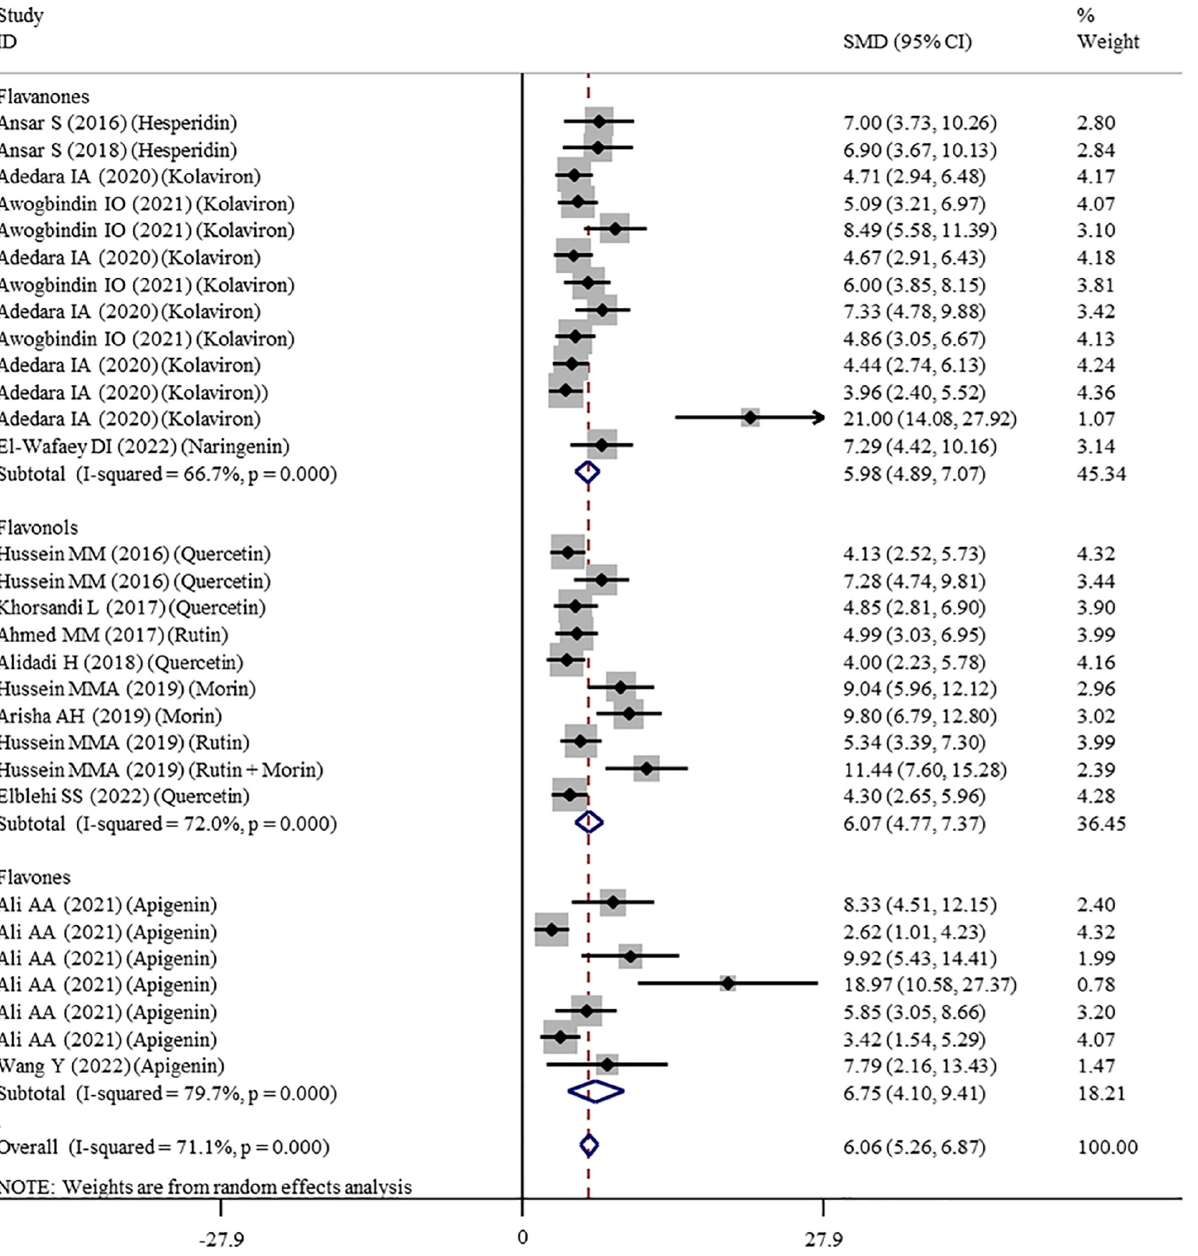
FIGURE 3 | Forest plots to show the effects of flavonoid supplementation on SOD levels compared with the nanomaterial exposure group. SOD, superoxide dismutase; SMD, standardized mean difference; CI, confidence